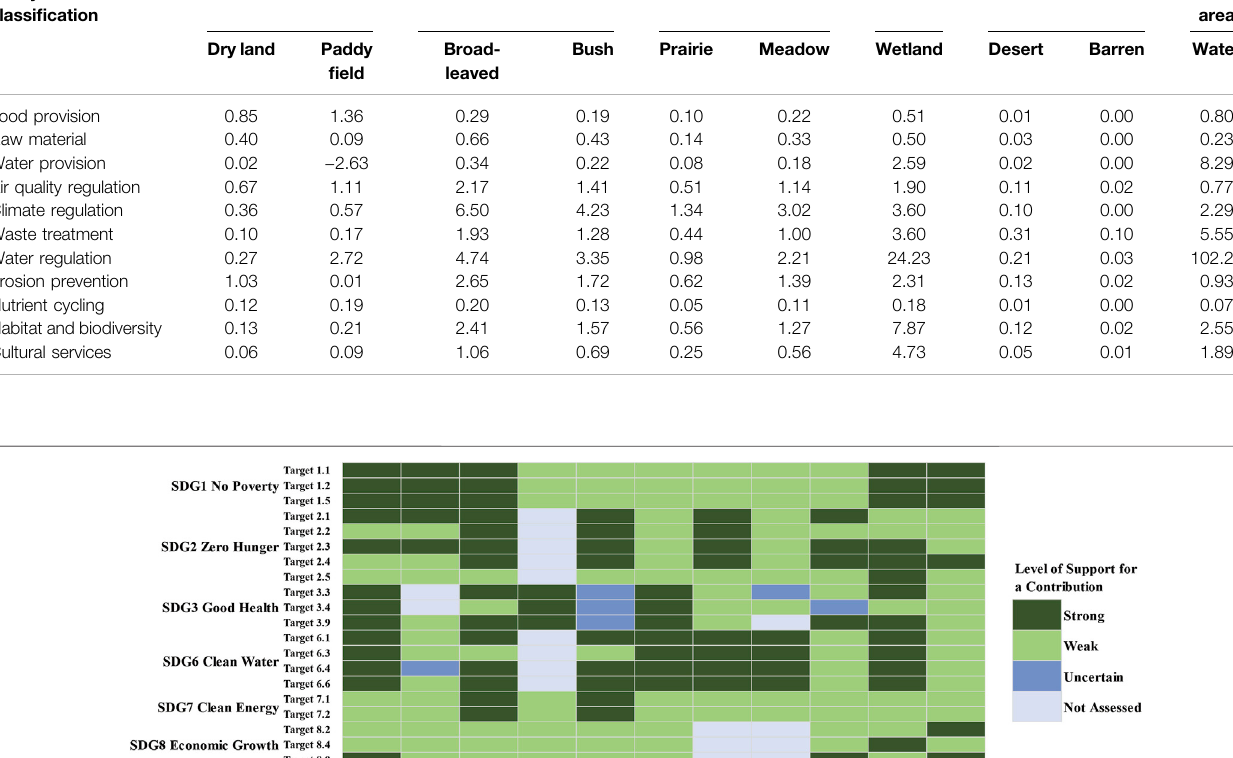
TABLE 1 | The equivalent coef fi cients for ecosystem service value per unit area in the Beijing-Tianjin-Hebei region. Ecosystem classi fi cation